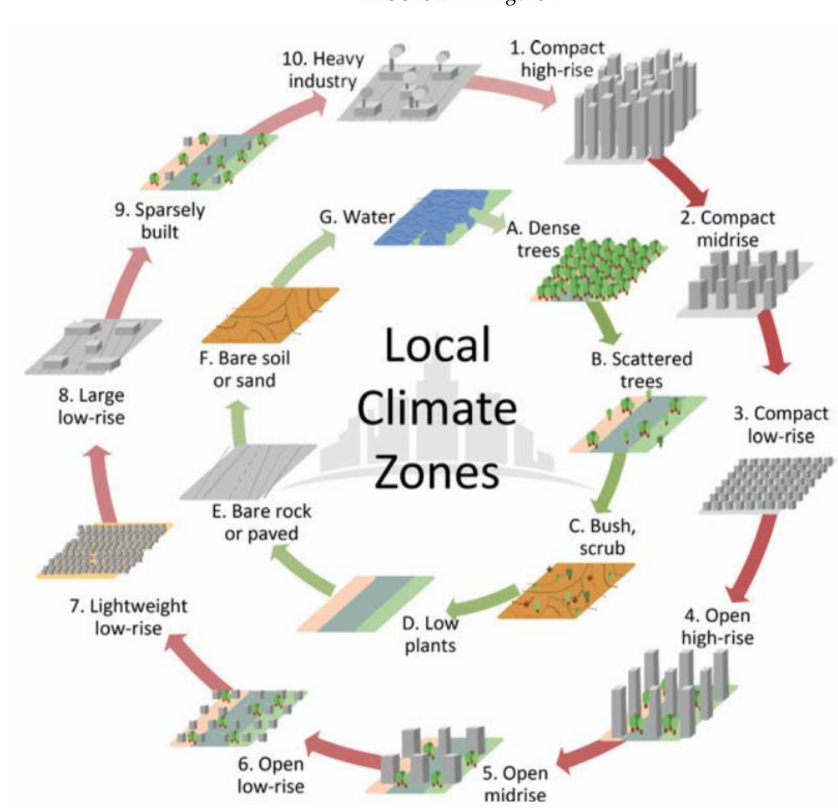
Figure 1. Definitions of the LCZs (image from Bechtel et al. [33], adapted from Stewart and Oke